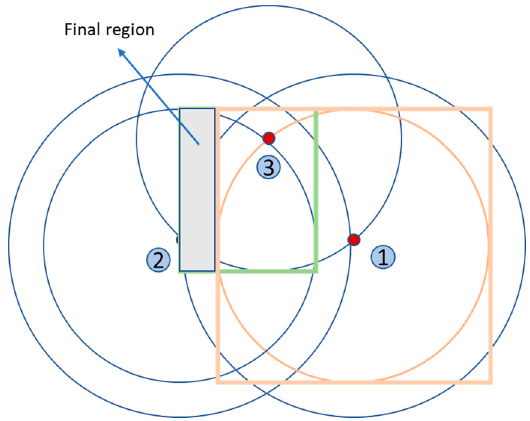
Figure 12. Final region of the area (2,1,1).